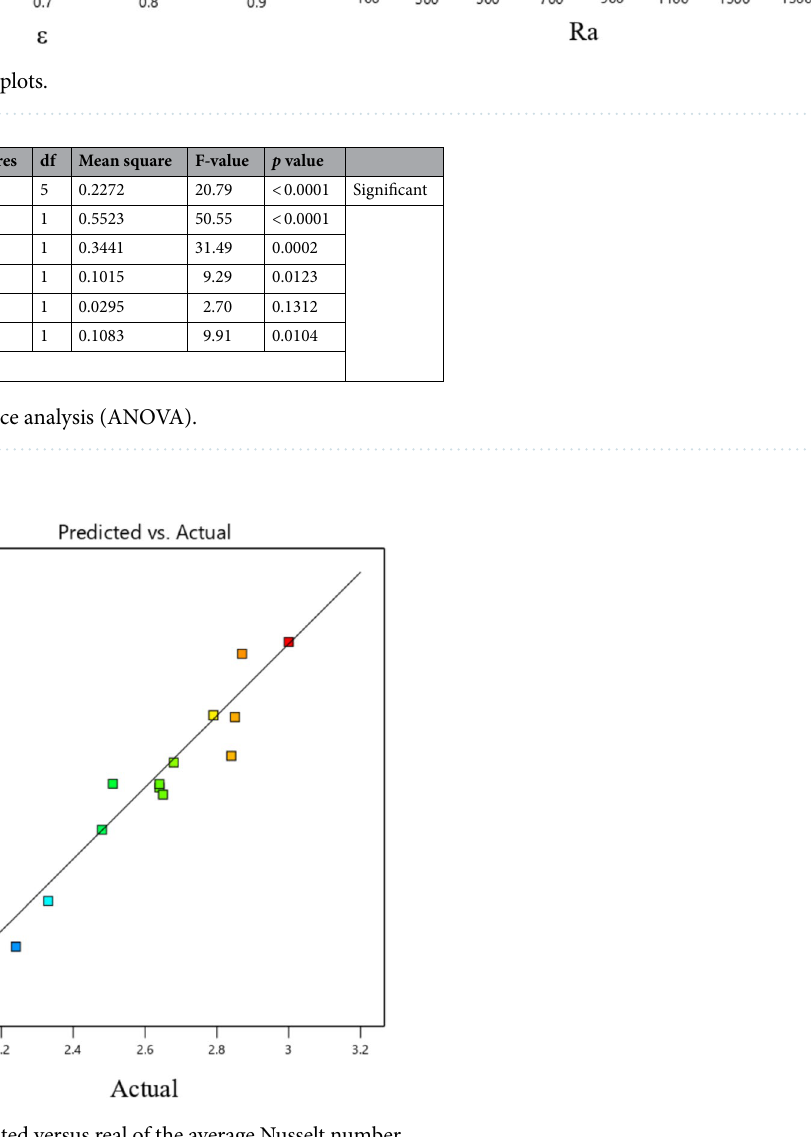
Figure 26. Anticipated versus real of the average Nusselt